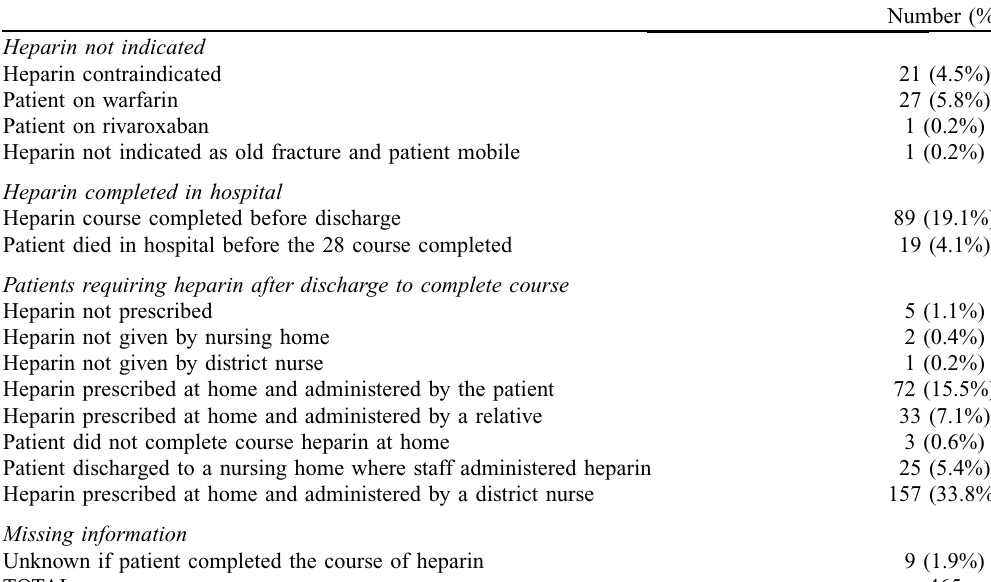
Table 2. Number of thromboembolic and bleeding complications over the two-year periods.